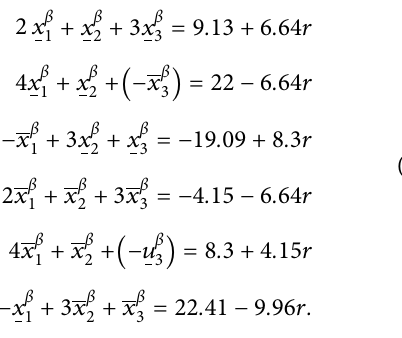
Figure 11: Te confdence chart of 􏽥 U